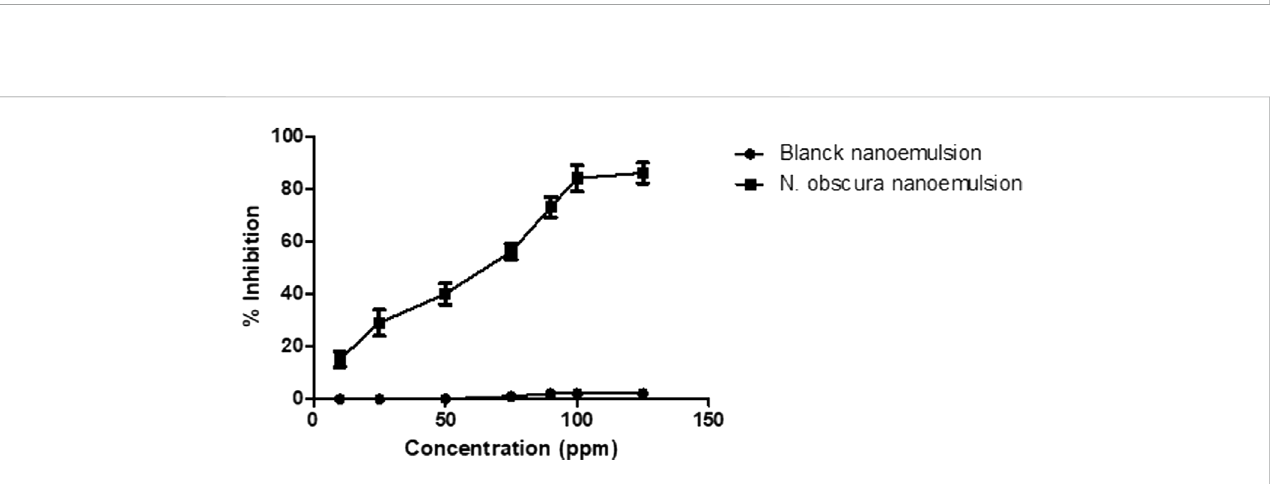
Inhibition percentage of NE against anti-cholinesterase activity. These experiments were performed in triplicate at least three distinct